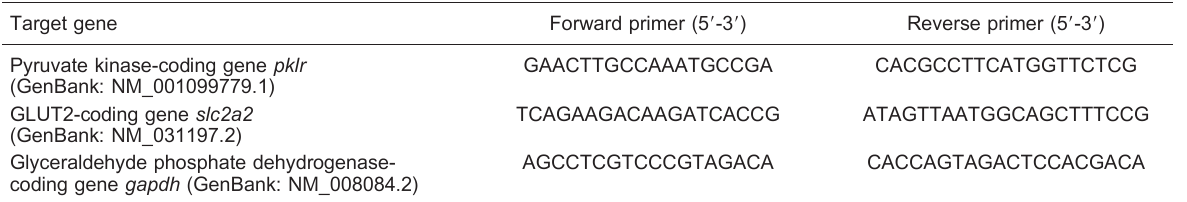
Table 1. Primers for semi-quantitative reverse transcript PCR assay. Target gene